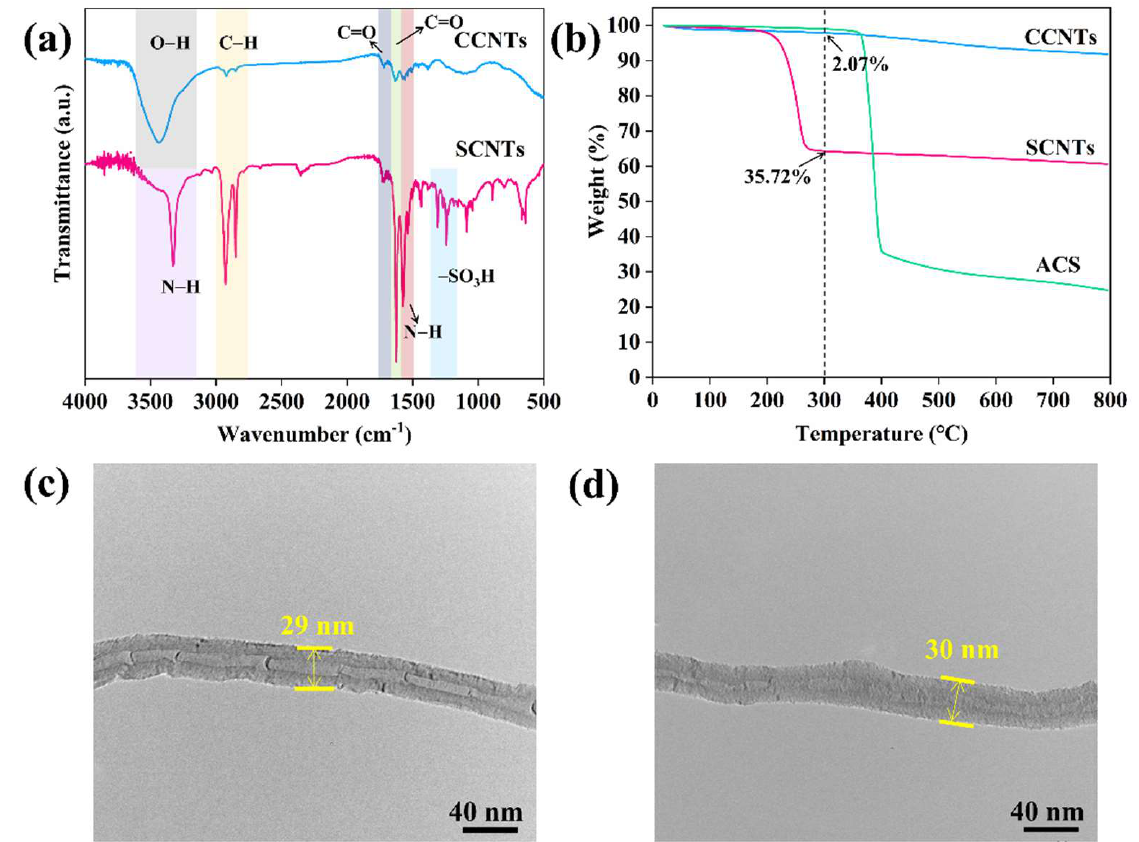
Figure 3. ( a ) FTIR spectra (the values were shifted vertically for clarity) and ( b ) TGA curves of CCNTs and SCNTs; TEM images of ( c ) CCNTs and ( d ) SCNTs.